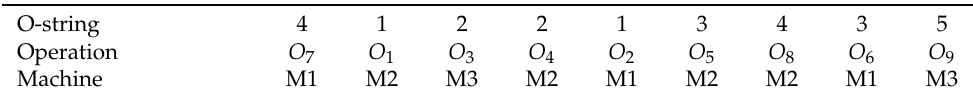
Table 2. A feasible chromosome for product